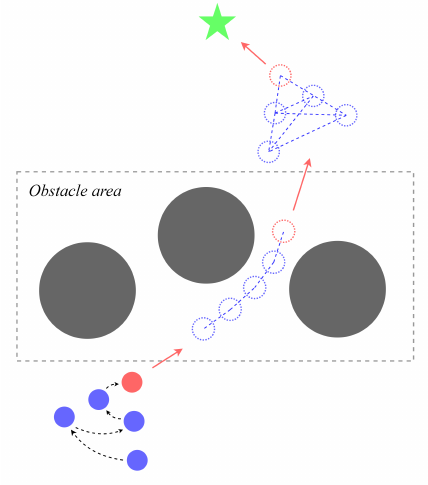
Figure 3. Toggle formation